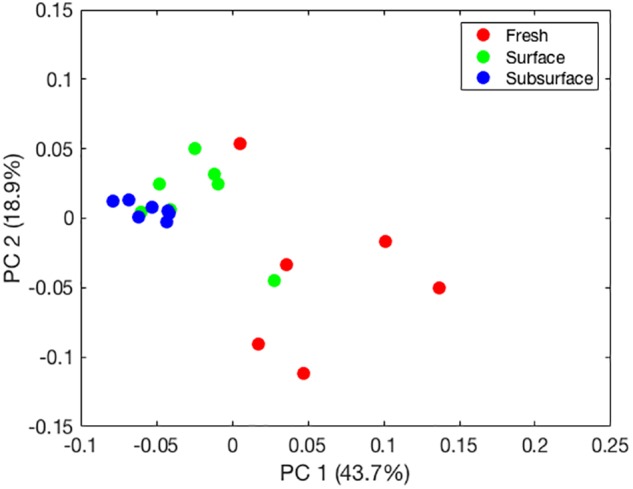
Principal component plot of bat guano bacterial community composition based on weighted UniFrac distances generated for fresh, surface, and subsurface bat guano.